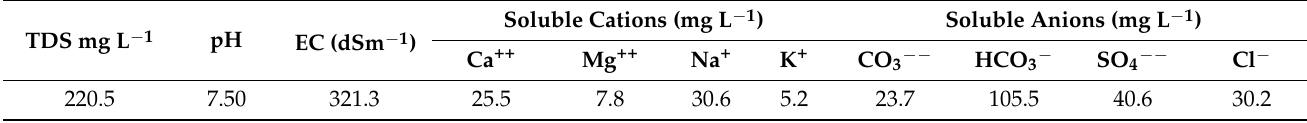
Table 2. Chemical analysis of the used irrigation water for the experimental site.